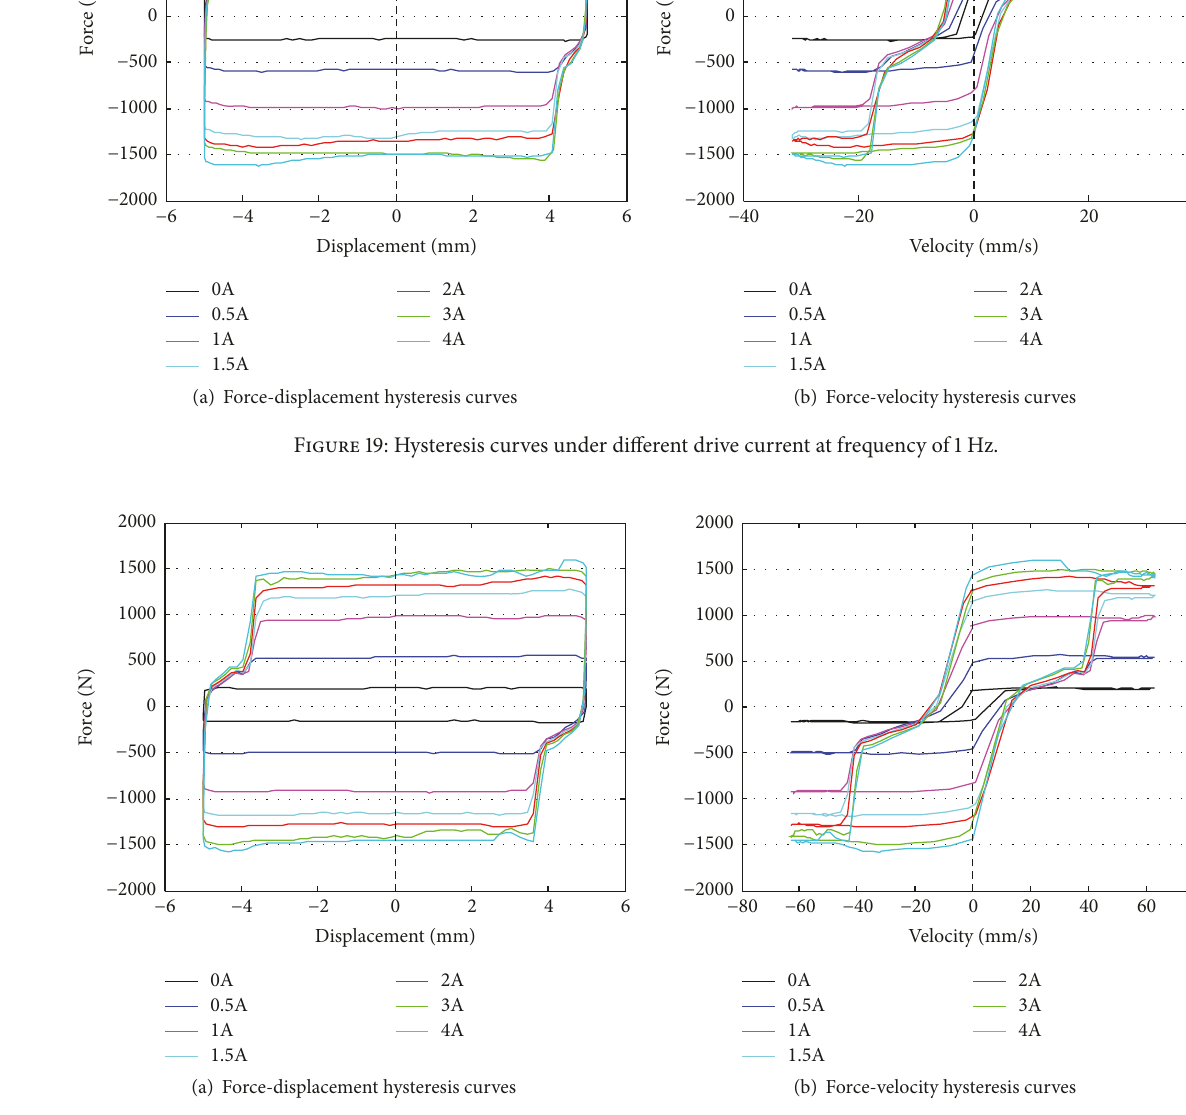
Figure 20: Hysteresis curves under different drive current at frequency of 2